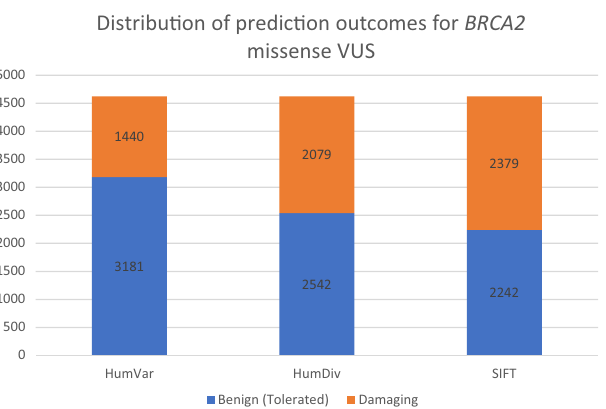
Figure 6. Summary of distribution of prediction outcomes on BRCA2 missense